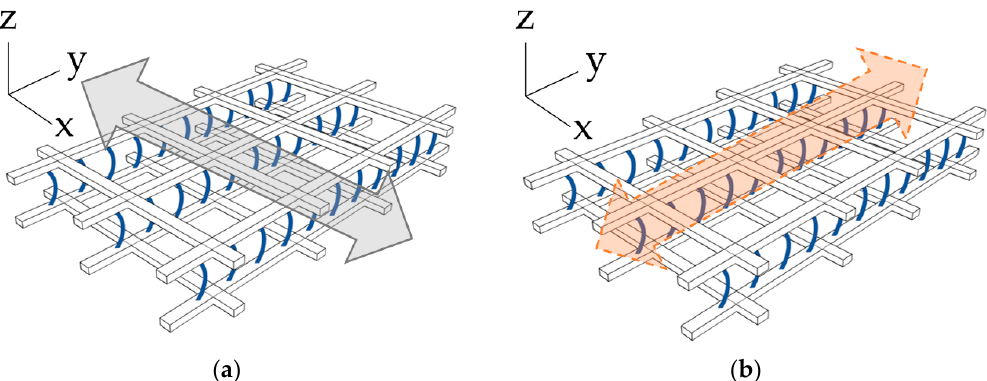
Figure 8. Schematic representation of loading in ( a ) x-direction, ( b ) y-direction for the knitted 3D TRC system.